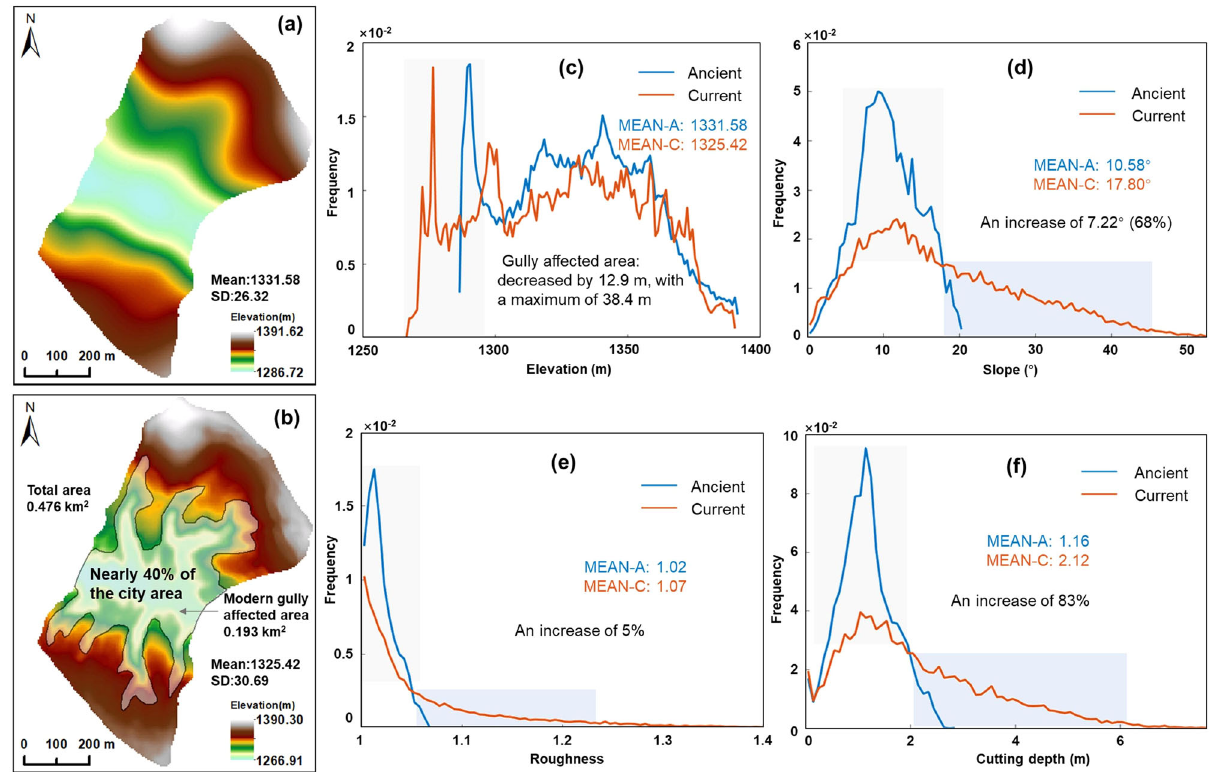
Fig. 2 Comparison of the ancient and modern terrain surfaces of Wucheng. a and b refer to the elevations of the ancient terrain surface and current terrain surface, respectively. c – f refer to the differences in the frequency distribution of elevation, slope, roughness and cutting depth between ancient and modern terrain surfaces, respectively. The results of the reconstructed surface morphology of the pre-Han Dynasty archaeological city with different interpolation approaches are shown in Supplementary Fig.